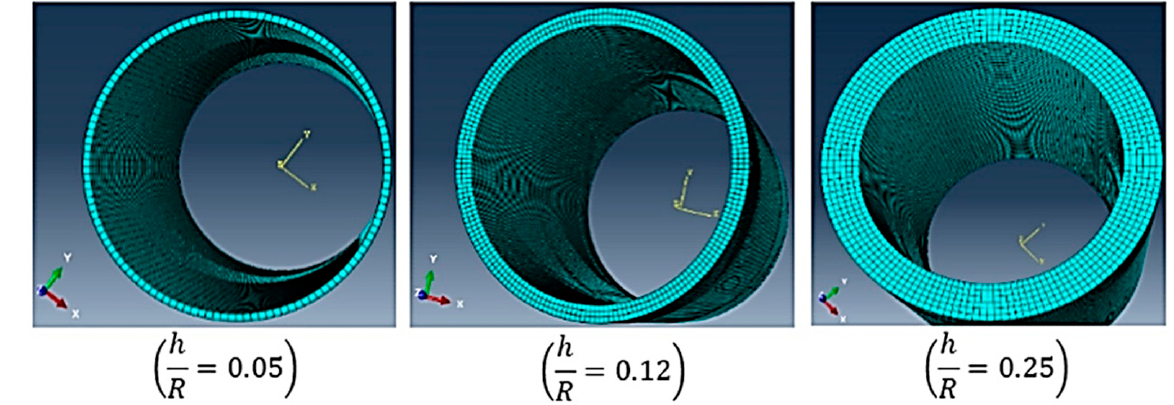
Figure 6. Meshing for different slenderness ratio with finite element solid 3D.